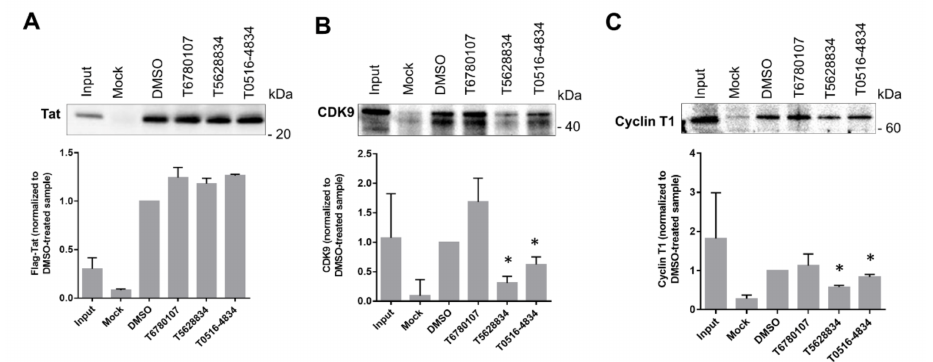
Figure 5. Effect of TAR RNA-targeting compounds on Tat interaction with CDK9/Cyclin T1. Tat precipitated from 293T cells co-transfected with Flag-Tat and, where indicated, treated with 20 µ M compounds. Protein levels were determined by Western blotting. ( A ) Tat expression determined by anti-Flag antibodies. ( B ) CDK9 protein expression determined using anti-CDK9 antibodies. ( C ) Level of cyclin T1 determined by anti-cyclin T1 antibodies. Quantification was performed using Prism 6 from three independent experiments. Asterisks indicate p < 0.01 in comparison to the DMSO